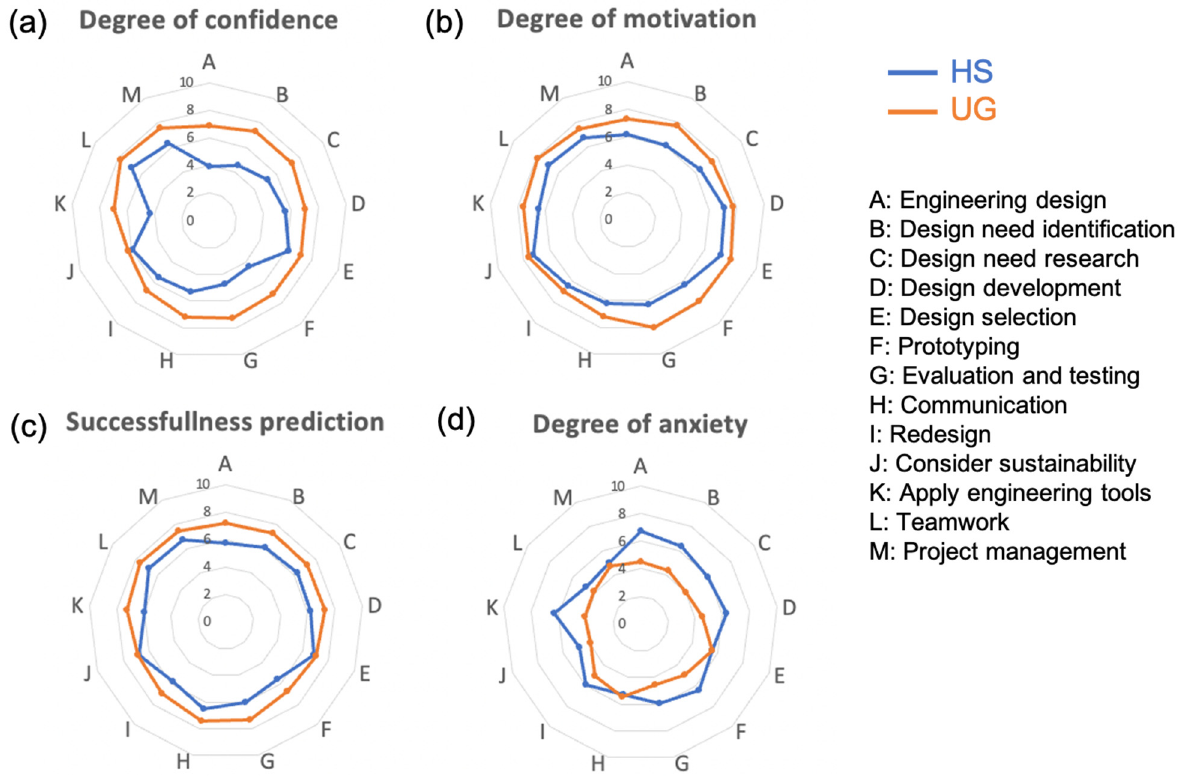
Figure 3. Radar plots showing grades on a scale from 0 (lowest grade) to 10 (highest grade) relative to participants’ ( a ) degree of confidence, ( b ) degree of motivation, ( c ) rate of successfulness, and ( d ) degree of anxiety to achieve the tasks listed in the plot. The grades obtained from the high school students are in blue, and those of the undergraduate students are in orange.